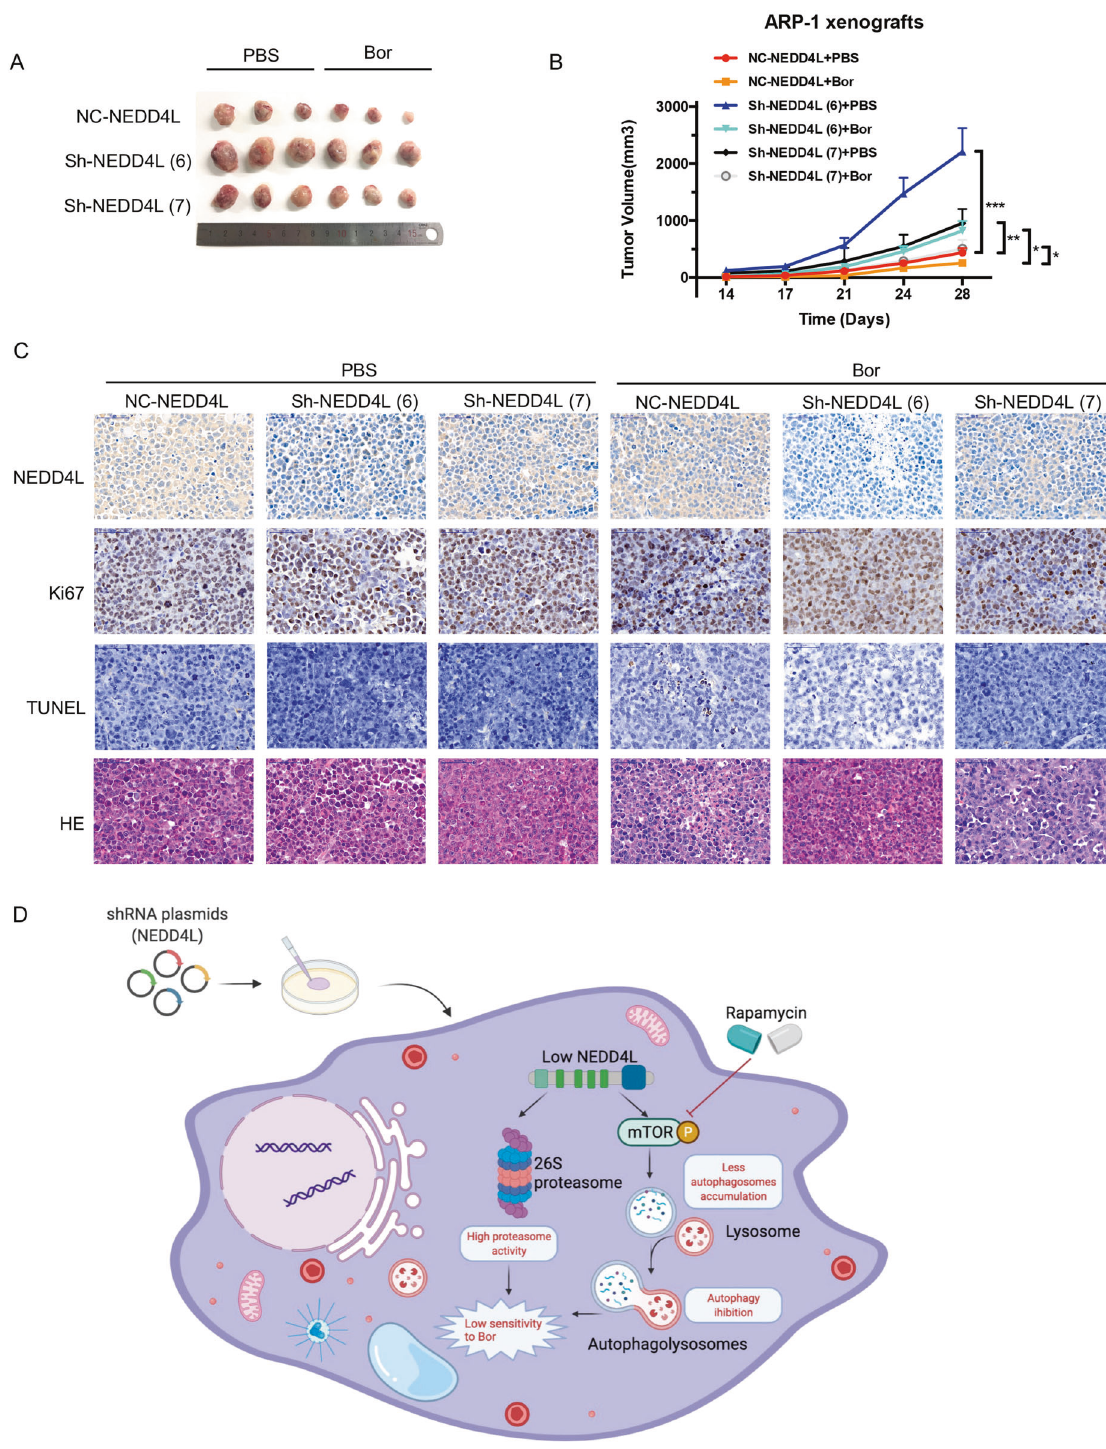
Fig. 6 NEDD4L KD decreased the sensitivity of MM cells to Bor in vivo. A , B Tumor volumes measured by Vernier calipers in the six different groups (three mice per group). C Immunohistochemical analysis was performed to detect NEDD4L, HE, Ki67, and TUNEL (magni fi cation: 400×). D Schematic model of NEDD4L in MM